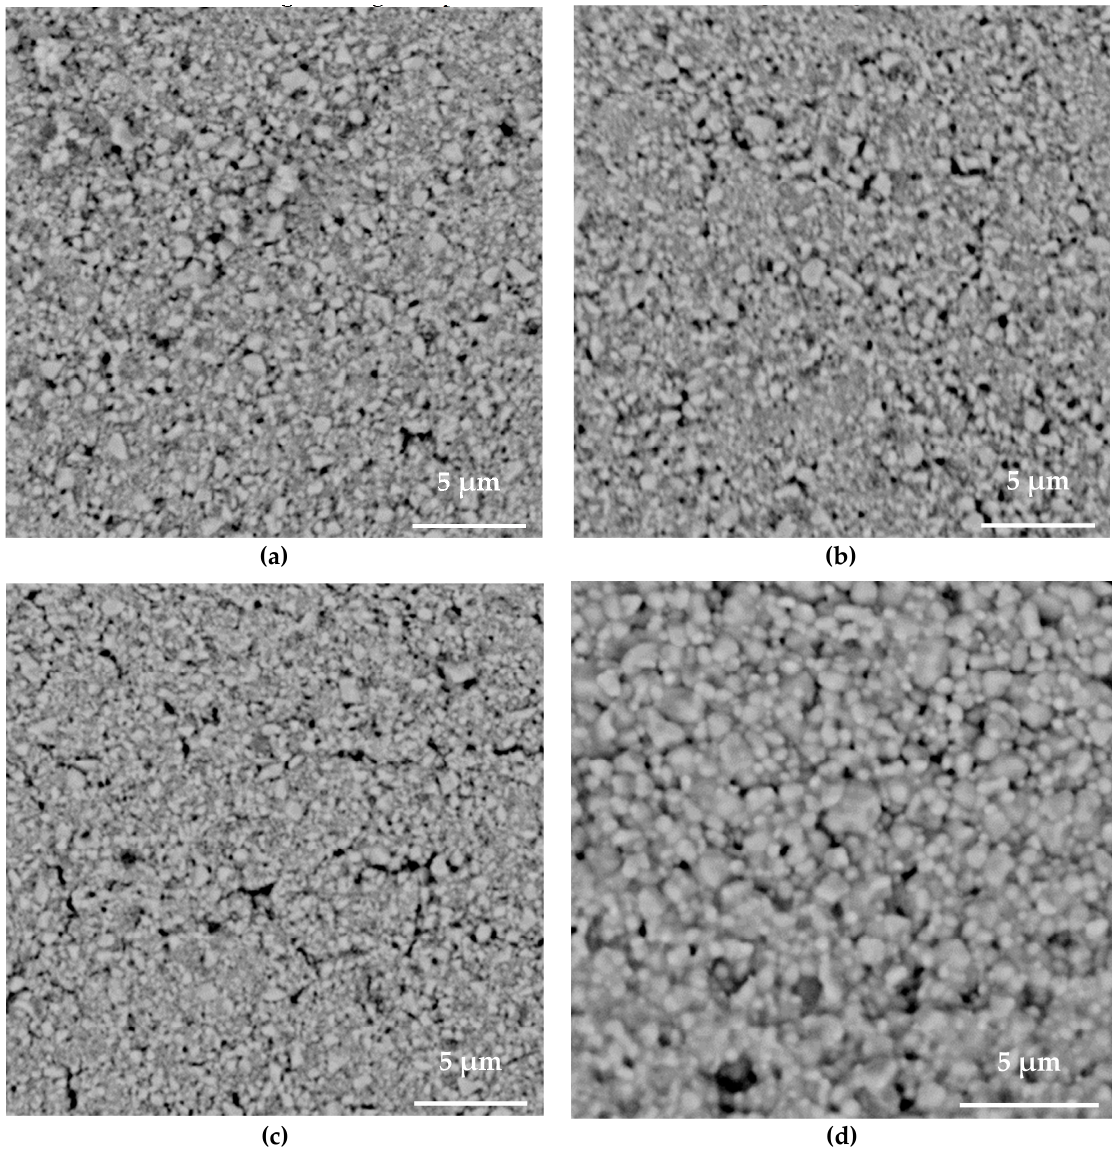
Figure 8. SEM images of PZT laser sintered using ( a ) 40%, ( b ) 60%, ( c ) 80% and ( d ) 100% power. To check the sintering results along the transverse cross-section, SEM images were taken along the thicknesses of the samples. The images are shown in Figure 9. The lower region near the substrate in the laser-sintered samples had a visibly different appearance compared with the upper region. The region near the top surface showed larger necking and fusing behaviour. In the lower region away from the top surface, there may have been less sintering, leading to a different appearance. A reason for this could be that there was a temperature gradient from the laser method, corroborating with the laser sintering model. A similar trend was observed for the composite sample.